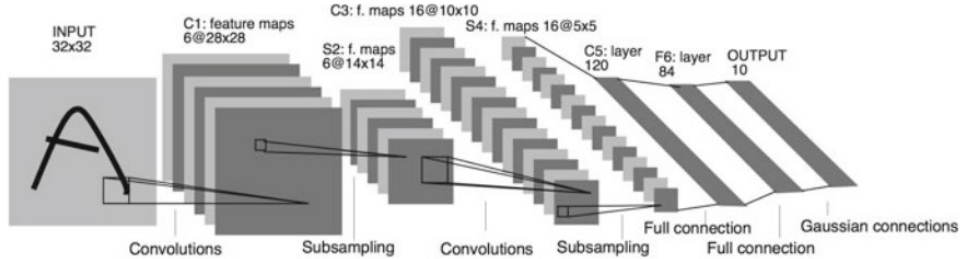
Figure 10. Architecture of LeNet [129].